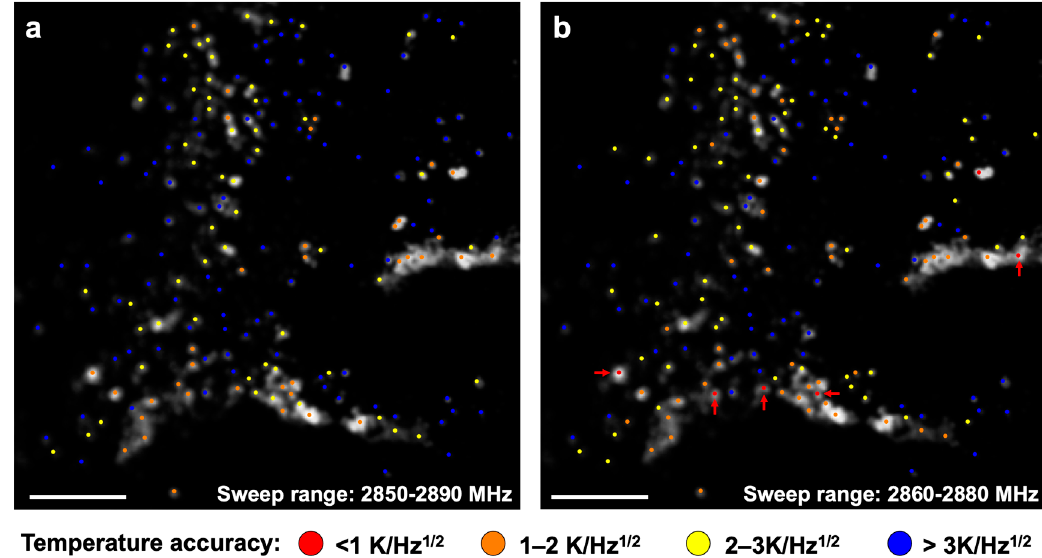
Figure 2. Temperature accuracies obtained by wide-field ODMR measurements of fluorescent nanodiamonds. Fluorescent image of the fluorescing nanodiamonds. The ODMR frequency spectra were obtained at the bright spots indicated by the colored dots. Temperature determination accuracies at each of the bright spots from the ( a ) 2850–2890 MHz and ( b ) 2860–2880 MHz sweeps are shown. Scale bar: 40 μ m.